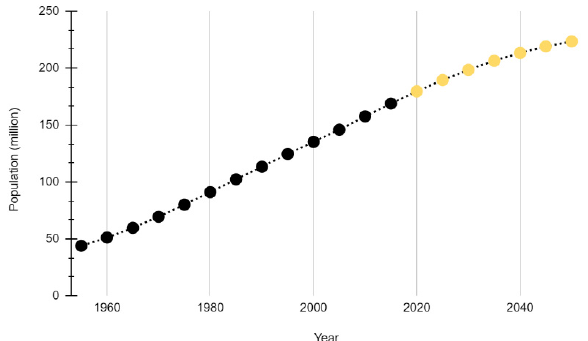
Figure 3. Population of Central America from 1950–2020 (black) and predicted population increase (yellow) through to 2050 [45].